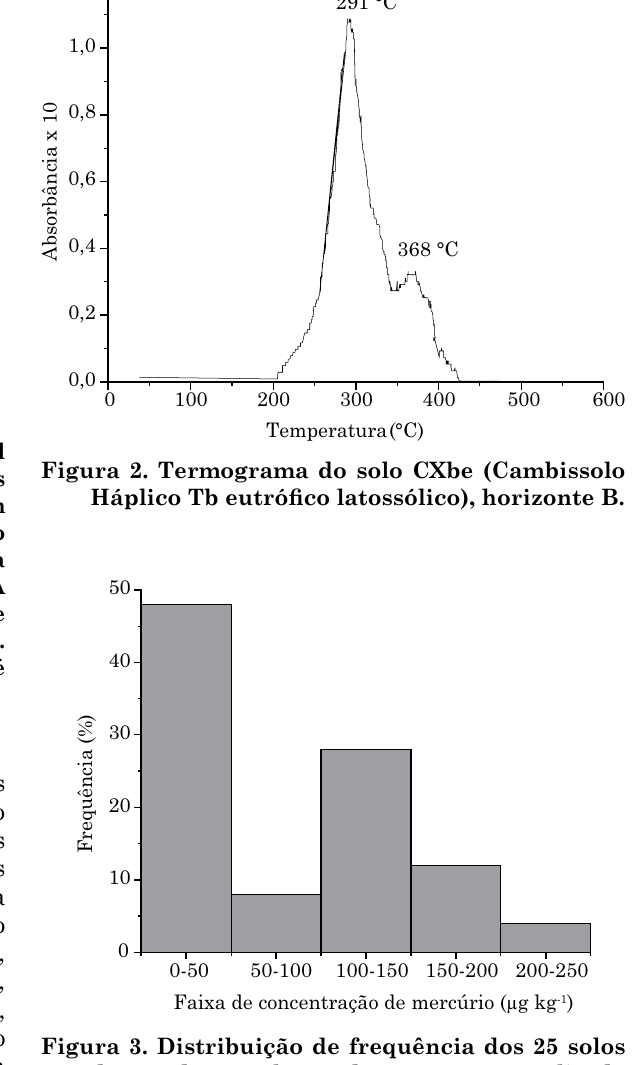
Figura 3. Distribuição de frequência dos 25 solos de acordo com classes de teores com amplitude de 50 μg kg -1 .